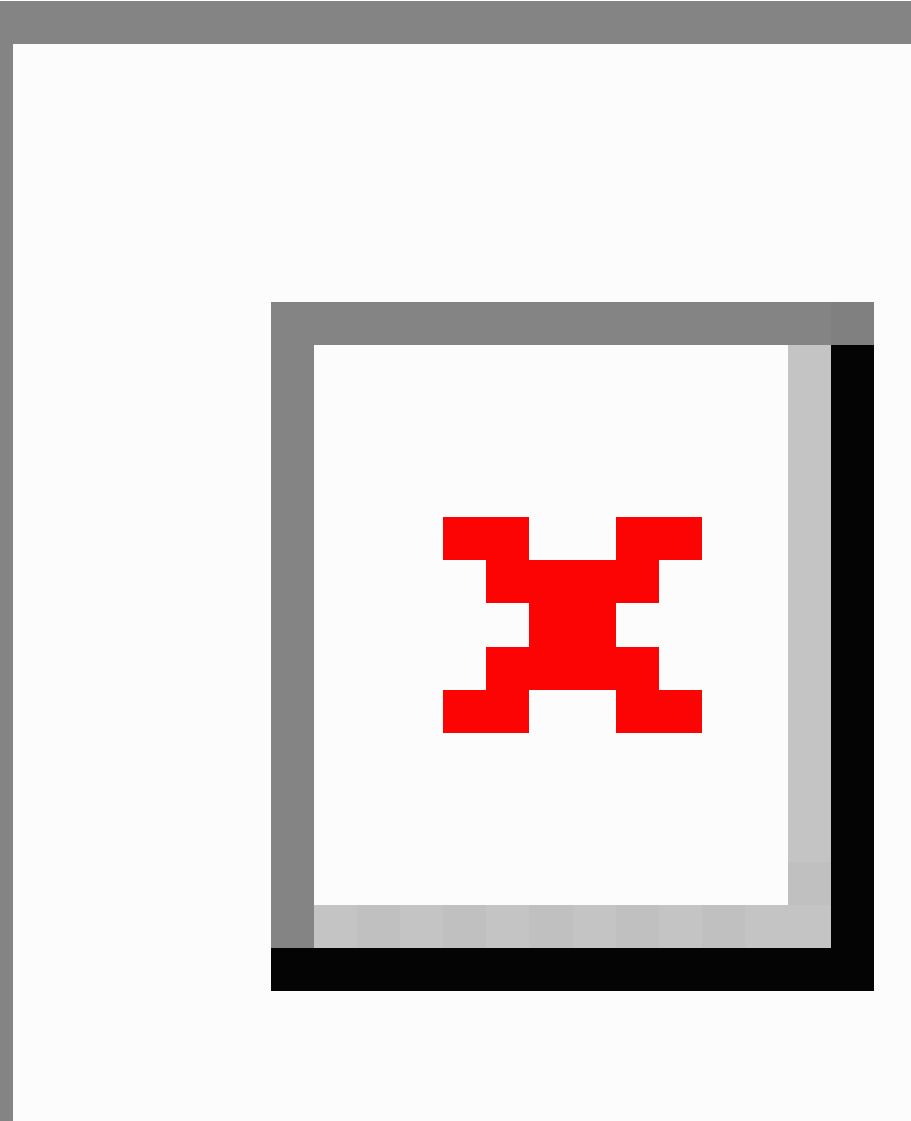
Figure 4. Logistic regression model of the median